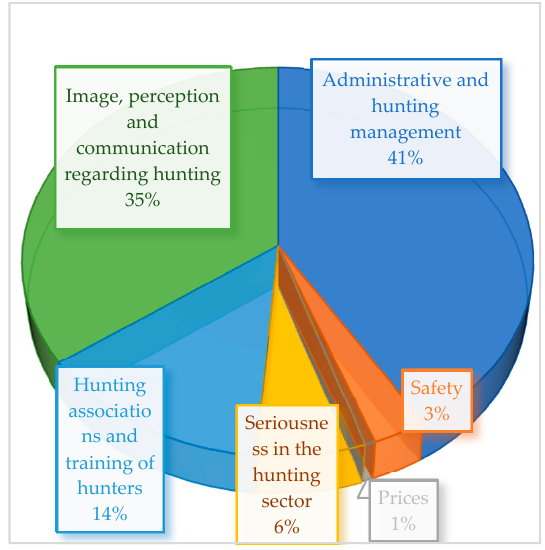
Figure 6. Romania. Figure 6. Romania.